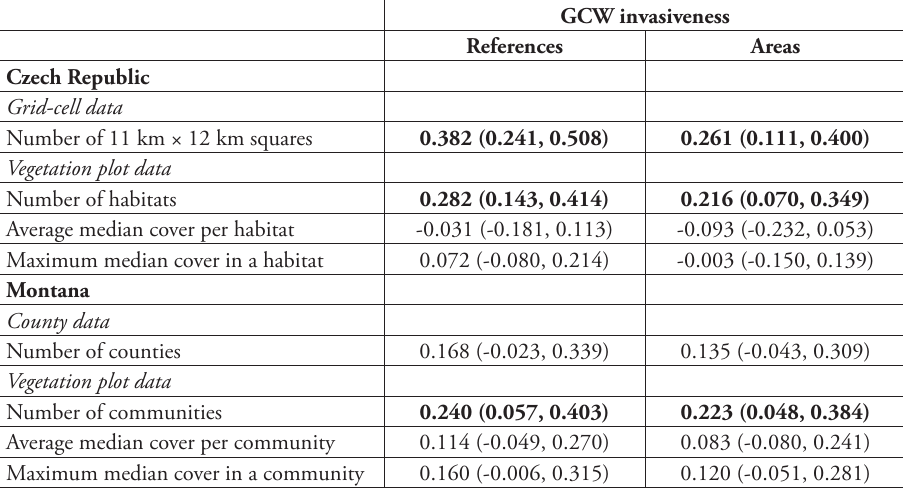
table 2. Spearman’s ρ correlation coefficients (and bootstrapped, bias-corrected 95% confidence in- tervals) of relationships between GCW-derived invasiveness measures and regional measures of species abundance and distribution from vegetation-plot data in the Czech Republic and Montana. Also given, for comparison, are correlations for the number of Czech Republic grid cells and the number of counties in Montana occupied by a species, using the subset of species occurring in the vegetation plot data for the respective regions. The values in bold are ρ coefficients, that are significantly greater than zero. GCW measures included number of references and the number of global regions according to the Global Com- pendium of Weeds with all non-target region references